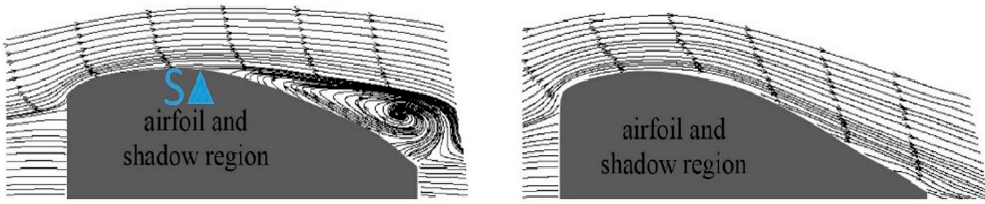
Figure 14. Mean-flow streamlines for Re = 64,200 and α = 9 degrees ( left ), 12.9 degrees ( right ). (Reprinted from [29]).